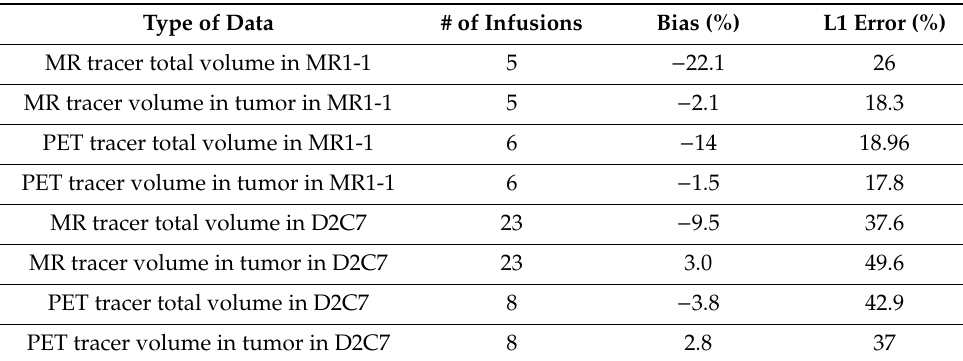
Table 2. Summary of error